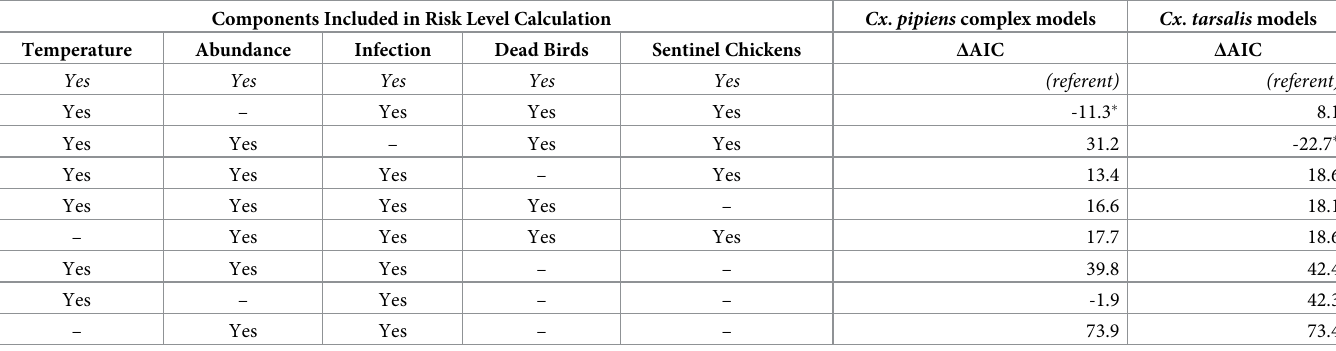
Table 3. Comparisons of models based on different calculations for risk level, ranked by Akaike Information (AIC). Components Included in Risk Level